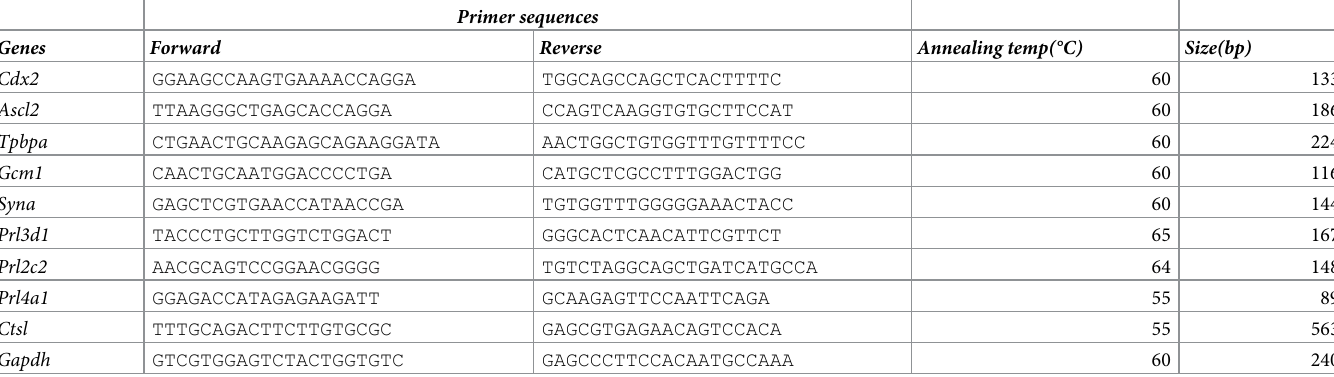
Table 1. Primers used for quantitative gene expression